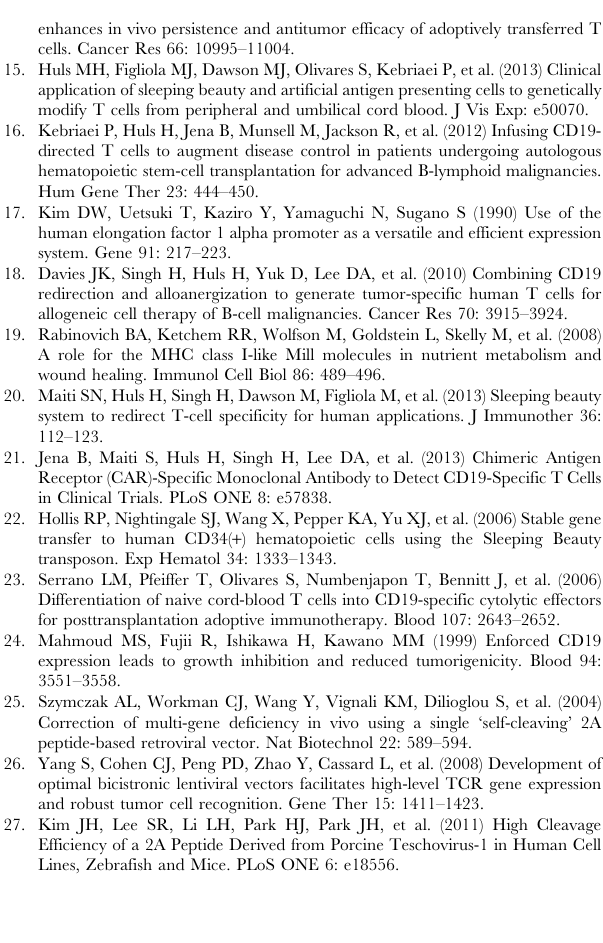
Table S6 Characterization of T cells before and after co-culture on c -irradiated aAPC. Table S7 In-process testing for electroporated and propagated T